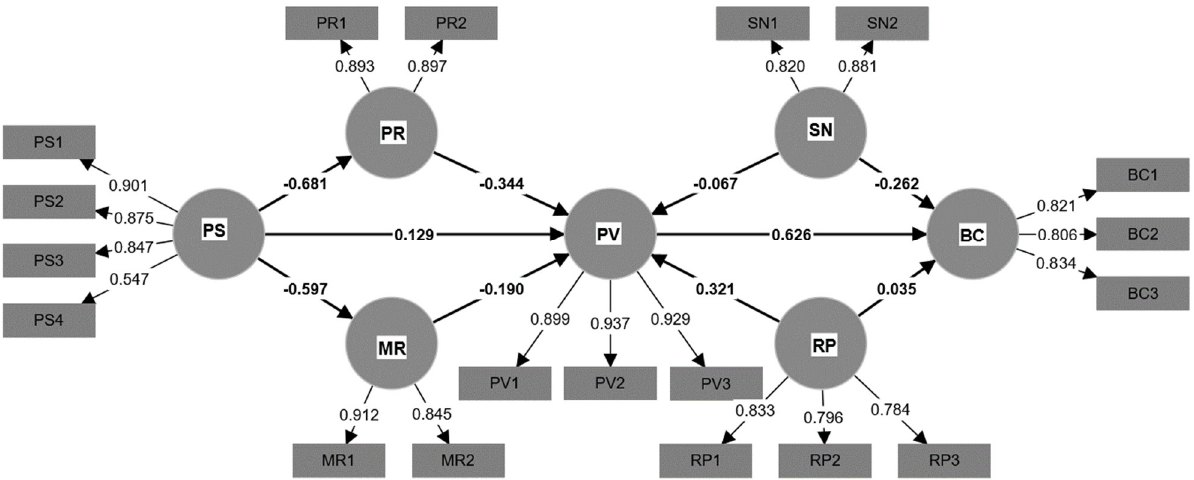
Figure 2. Path diagram with path coefficient to estimate research model. Source: Own calculations based on Smart PLS test